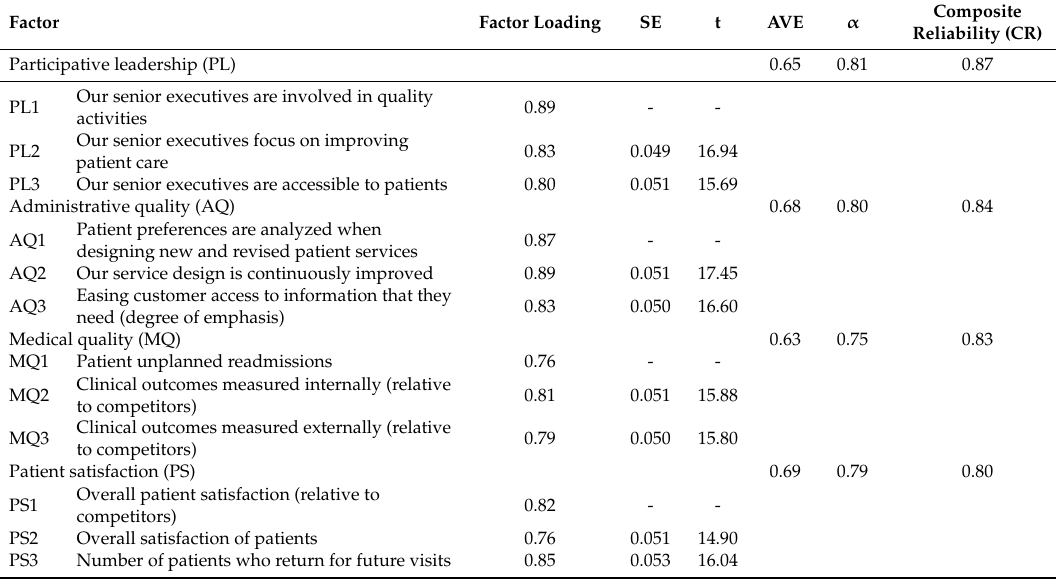
Table 2. Overall measurement